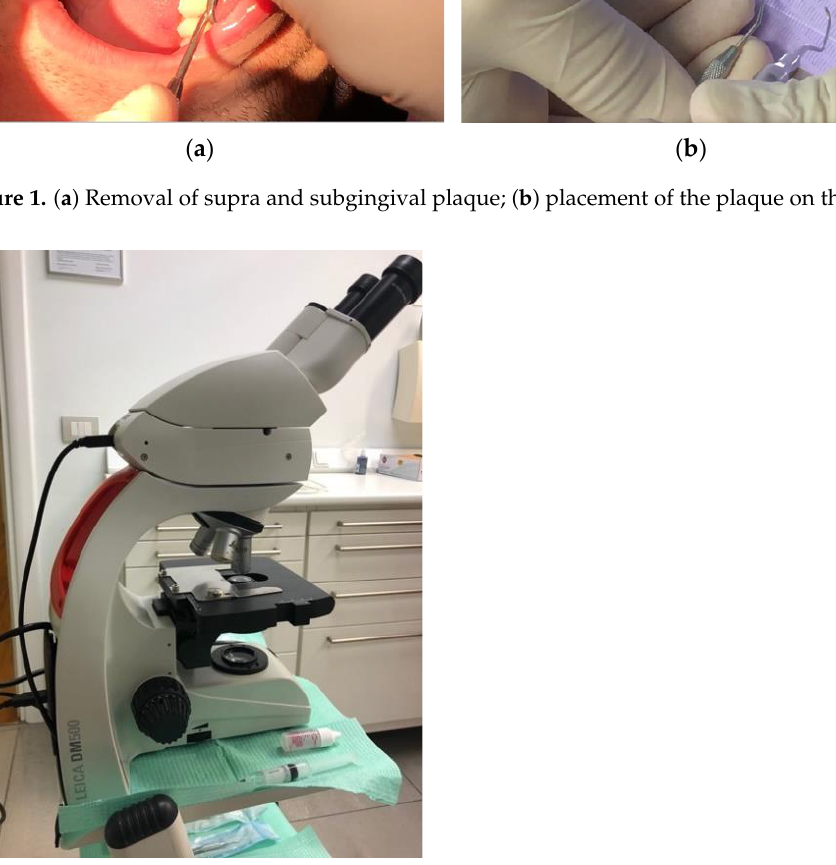
Figure 2. Contrast phase microscope in periodontal office.